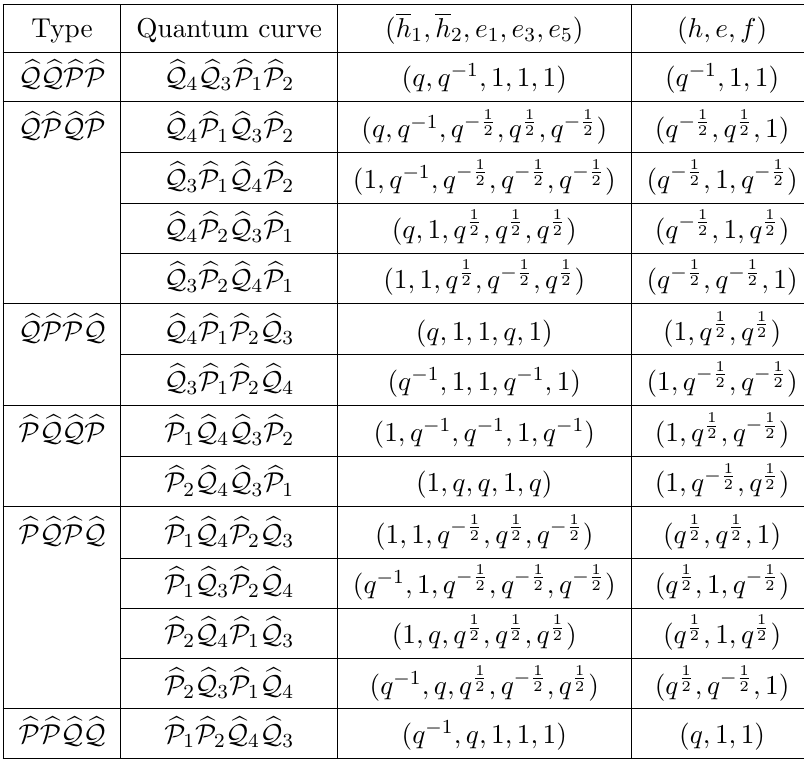
Table 2 . Quantum curves with a reference frame and labels speci(cid:12)ed and the corresponding point con(cid:12)gurations.